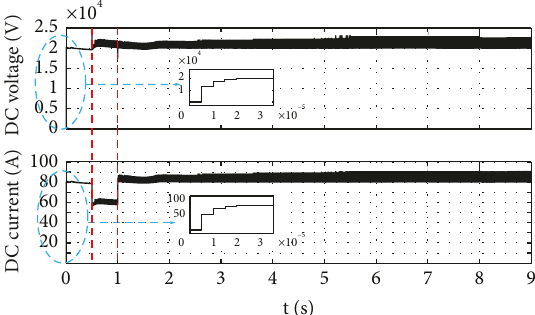
Figure 18: DC-side voltage and current at 0 ∼